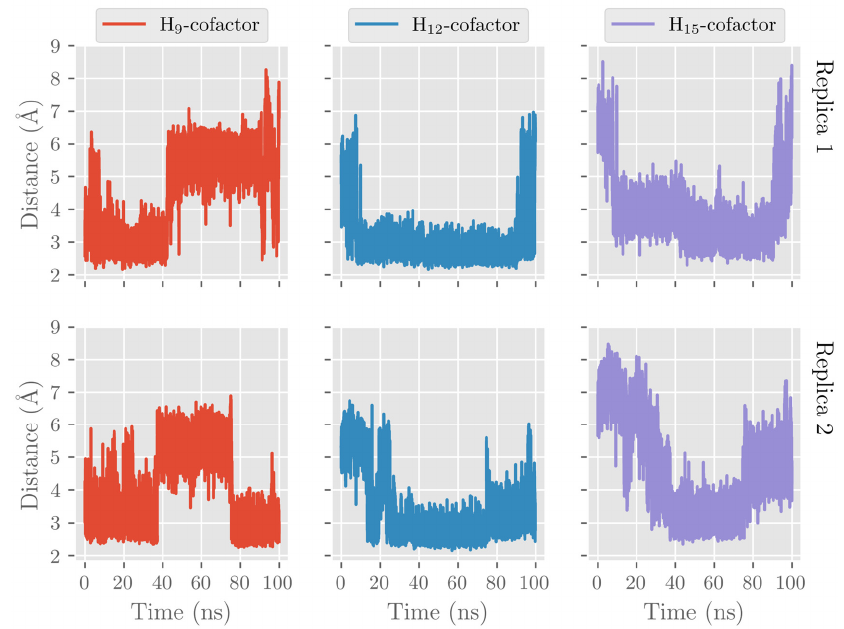
Figure 19. Evolution with time of the H 12 -OH − , H 9 -OH − , and H 15 -OH − distances along the MD replica 1 and replica 2 in pigALOX15-mini-LOX.